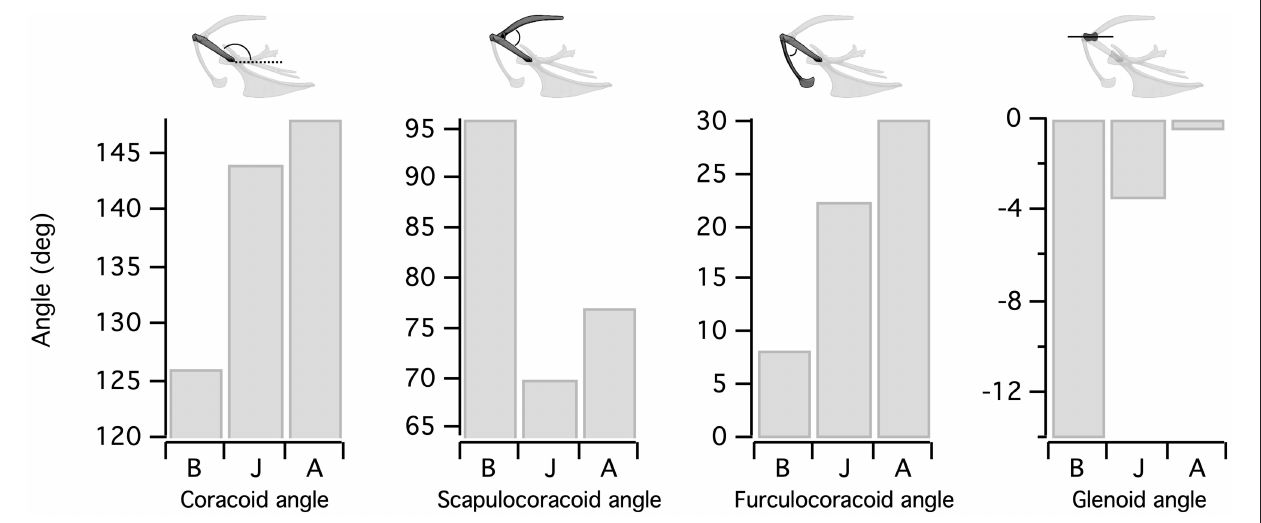
FIGURE 4 | Orientation of the flight apparatus. Elements of the pectoral girdle change orientation during avian ontogeny. Because the scapula remains close to the vertebral column, increases in coracoid angle are accompanied by decreases in scapulocoracoid angle. Simultaneously, the angle between the furcula and coracoid increases. Shifts in coracoid orientation also bring the glenoid more parallel to the vertebral column. B, Baby chukar; J, Juvenile chukar; A, Adult chukar.